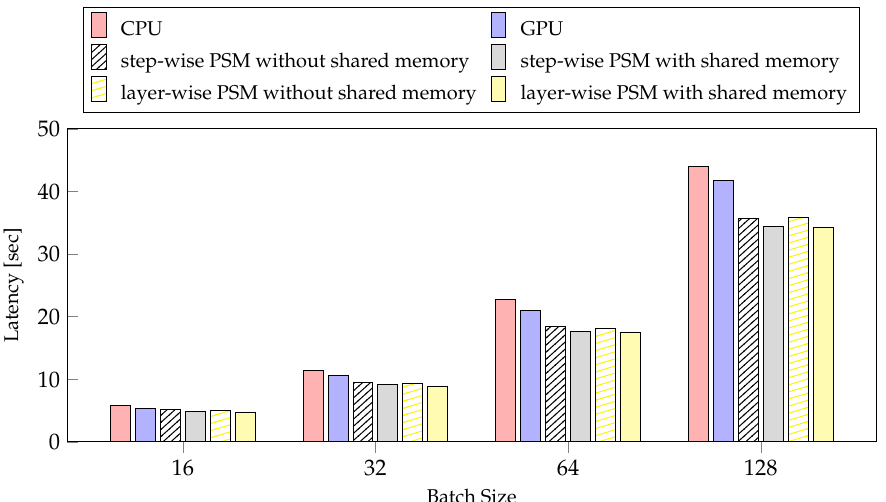
Figure 9. The experiments about latency of PSMs according to the batch